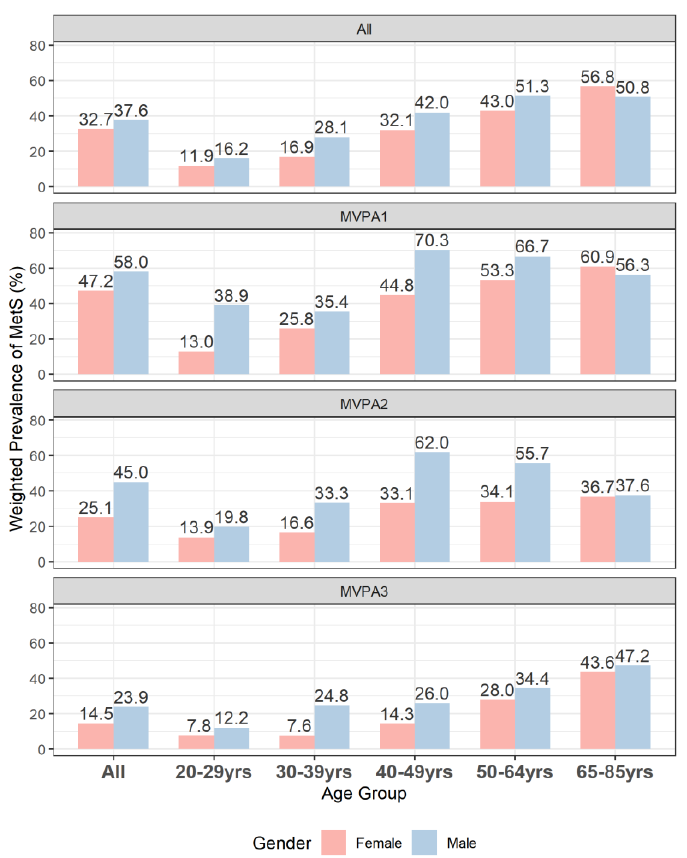
Figure 2. Weighted prevalence of metabolic syndrome. Bars represent metabolic syndrome prevalence (%) of male and female at each age quintile and at each tertile of MVPA time. ALL represents the case when the prevalence is not categorized by age or by MVPA time.